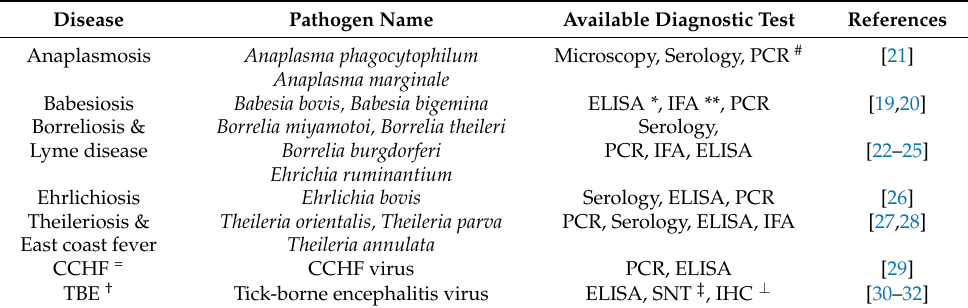
Table 1. Available diagnostic tests for tick-borne pathogens in cattle. Disease Pathogen Name Available Diagnostic